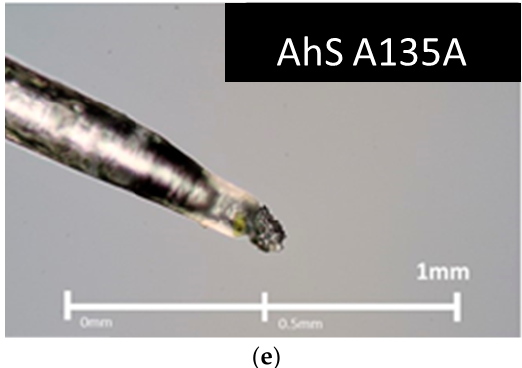
Figure 1. Graphite-bearing fragments glued on top of glass fibers 0.1 mm thick. ( a ) Almahata Sitta (AhS) 72. ( b ) AhS 209b1. ( c ) AhS 209b2. ( d ) AhS 209b4. ( e ) AhS A135A.